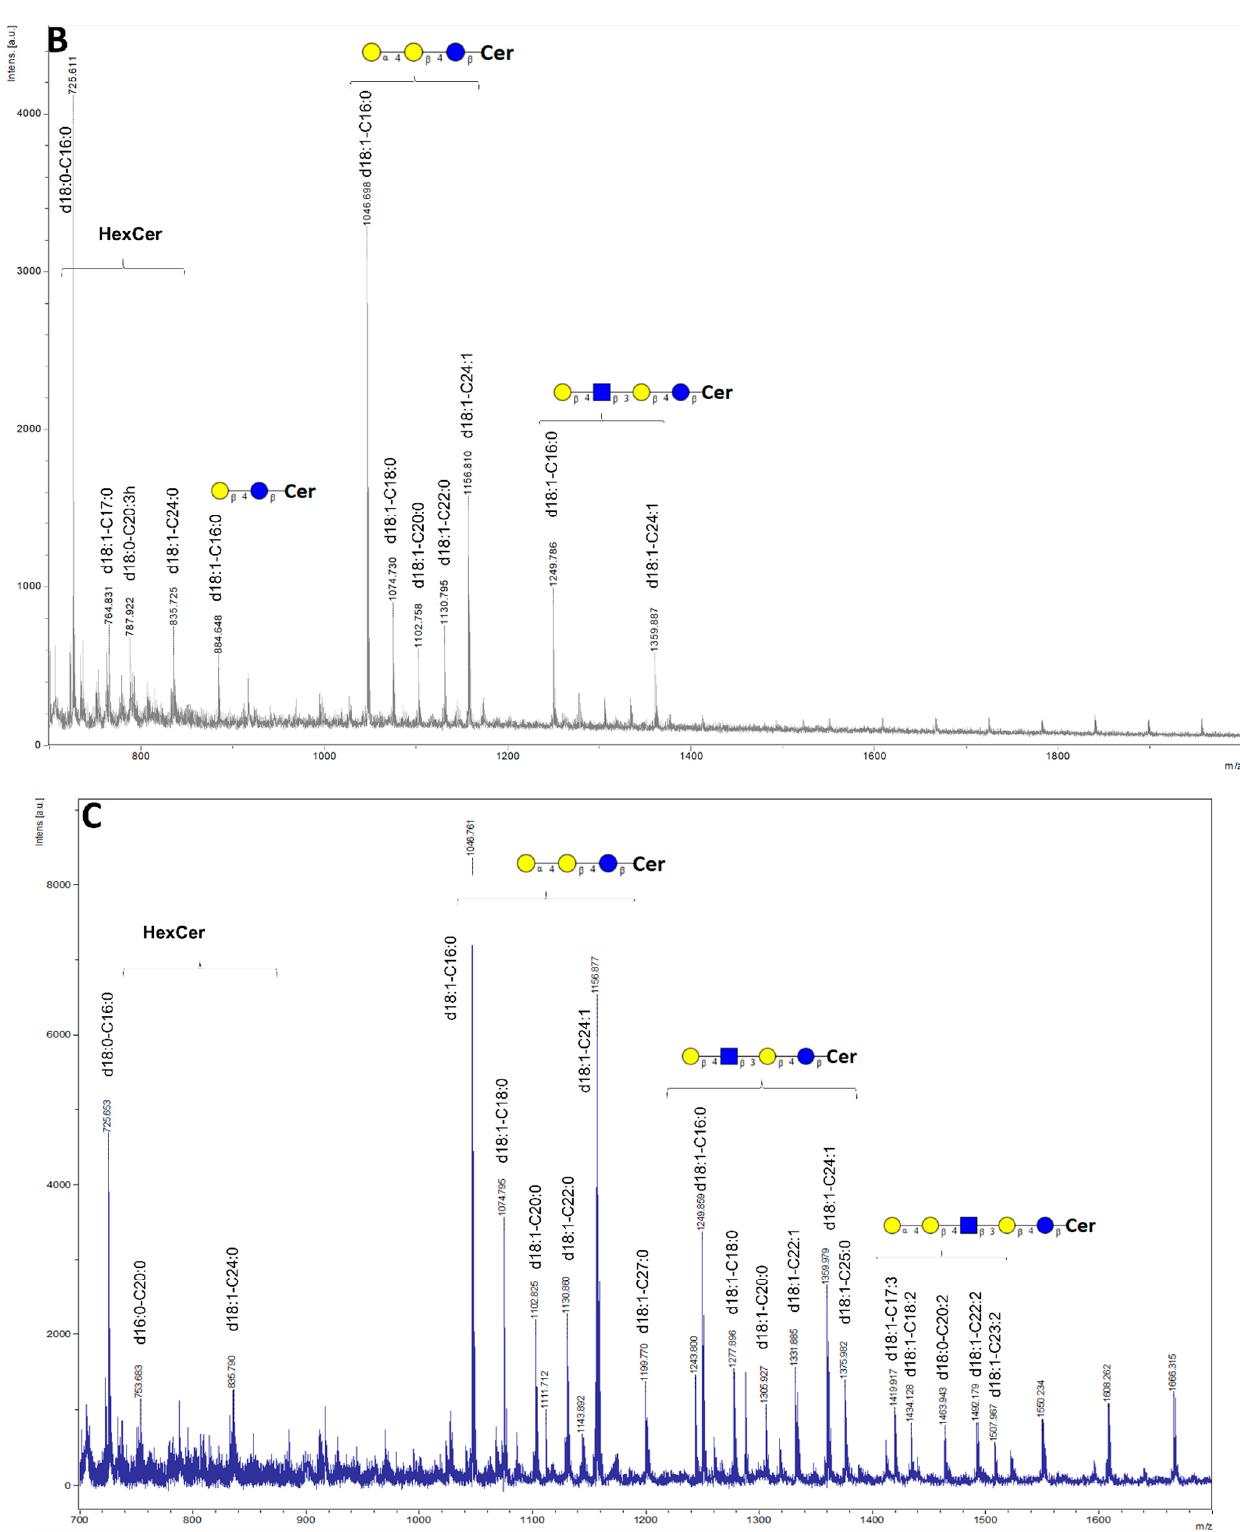
Figure 3. MALDI–TOF mass spectra of GSLs isolated from 2102Ep cells nontransfected or transfected with vectors encoding the M or P enzyme. ( A ) nontransfected 2102Ep cells; ( B ) 2102Ep cells transfected with vector encoding enzyme P; ( C ) 2102Ep cells transfected with vector encoding enzyme M. Individual peaks are annotated with predicted GSL structures (including the fatty acid chain length and saturation). The list of sugar symbols is shown in ( A ).